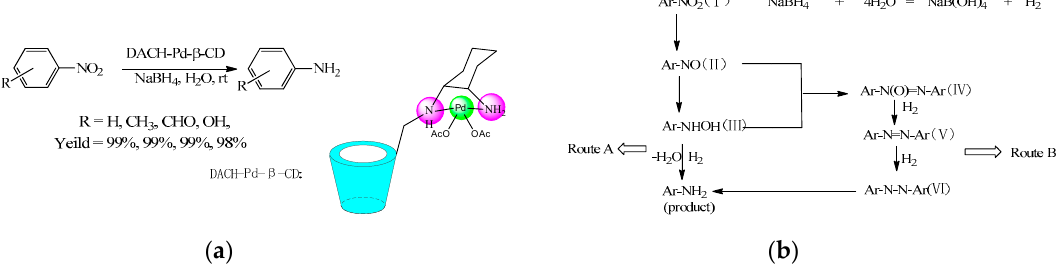
Scheme 7. ( a ) The reduction reaction of nitroarene catalyzed by DACH-Pd- β -CD; ( b ) the proposed mechanism pathways of nitroarene reduction.